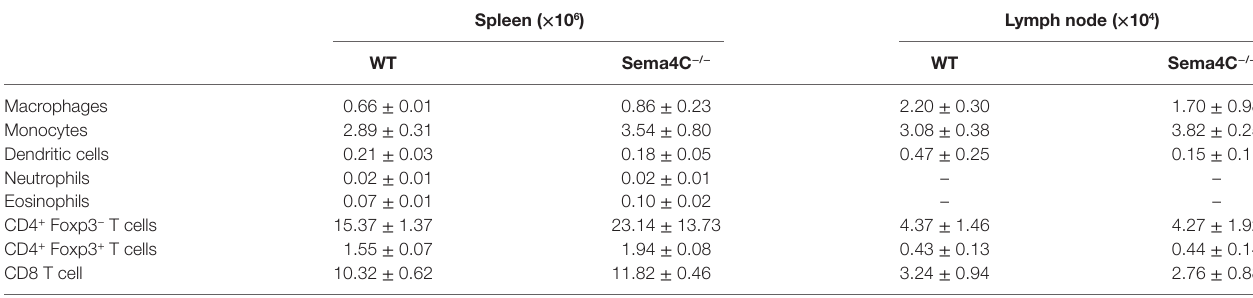
TaBle 3 | analysis of cell populations in WT and sema4c − / − naive mice in spleens and cervical lymph